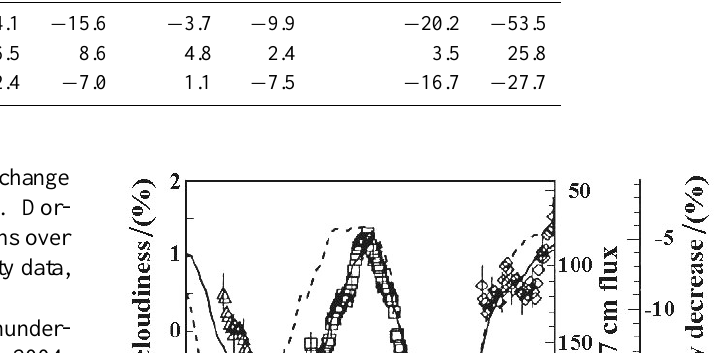
Table 1. Global annual mean forcing due to various types of clouds, from the Earth Radiation Budget Experiment (ERBE), according to Hartmann (1993). The positive forcing increases the net radiation budget of the Earth and leads to a warming; negative forcing decreases the net radiation and causes a cooling. (Note that the global fraction implies that 36.7% of the Earth is cloud free.) Parameter High clouds Middle clouds Low clouds Thin Thick Thin Global fraction/(%) Forcing (relative to clear sky):